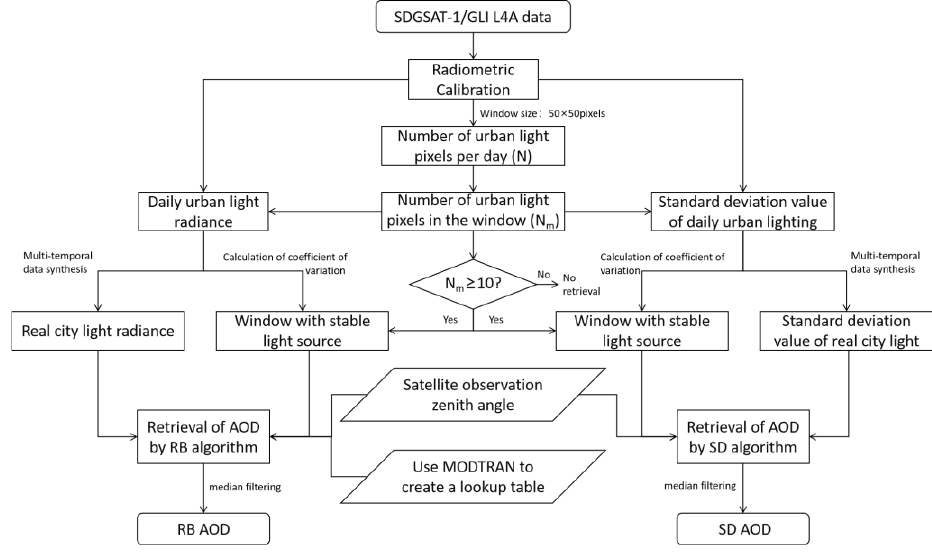
Figure 2. Flowchart of RB and SD algorithms for retrieving nighttime AOD.